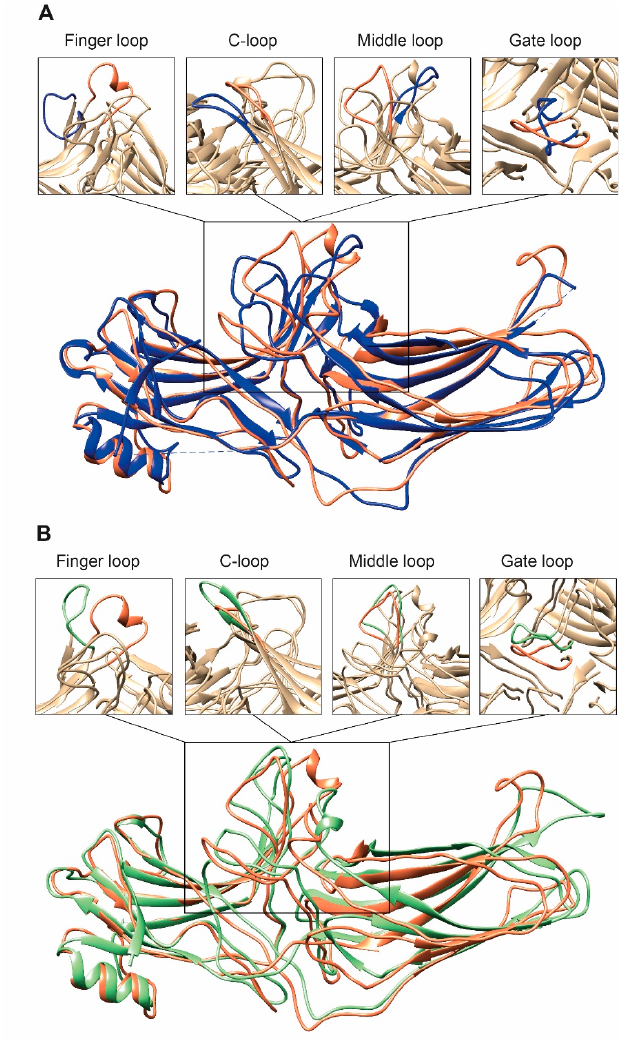
Figure 2. Comparison of arrestin-2 conformations in complex with M 2 R and NTS 1 R. ( A ) The crystal structures of arrestin-2 in the basal state (PDB: 1G4M, blue [17]) and in complex with NTS 1 R (PDB: 6UP7, orange [34]) are superimposed. ( B ) The crystal structures of arrestin-2 in complex with NTS 1 R (PDB: 6UP7, orange [34]) and in complex M 2 R (PDB: 6U1N, green [33]) are